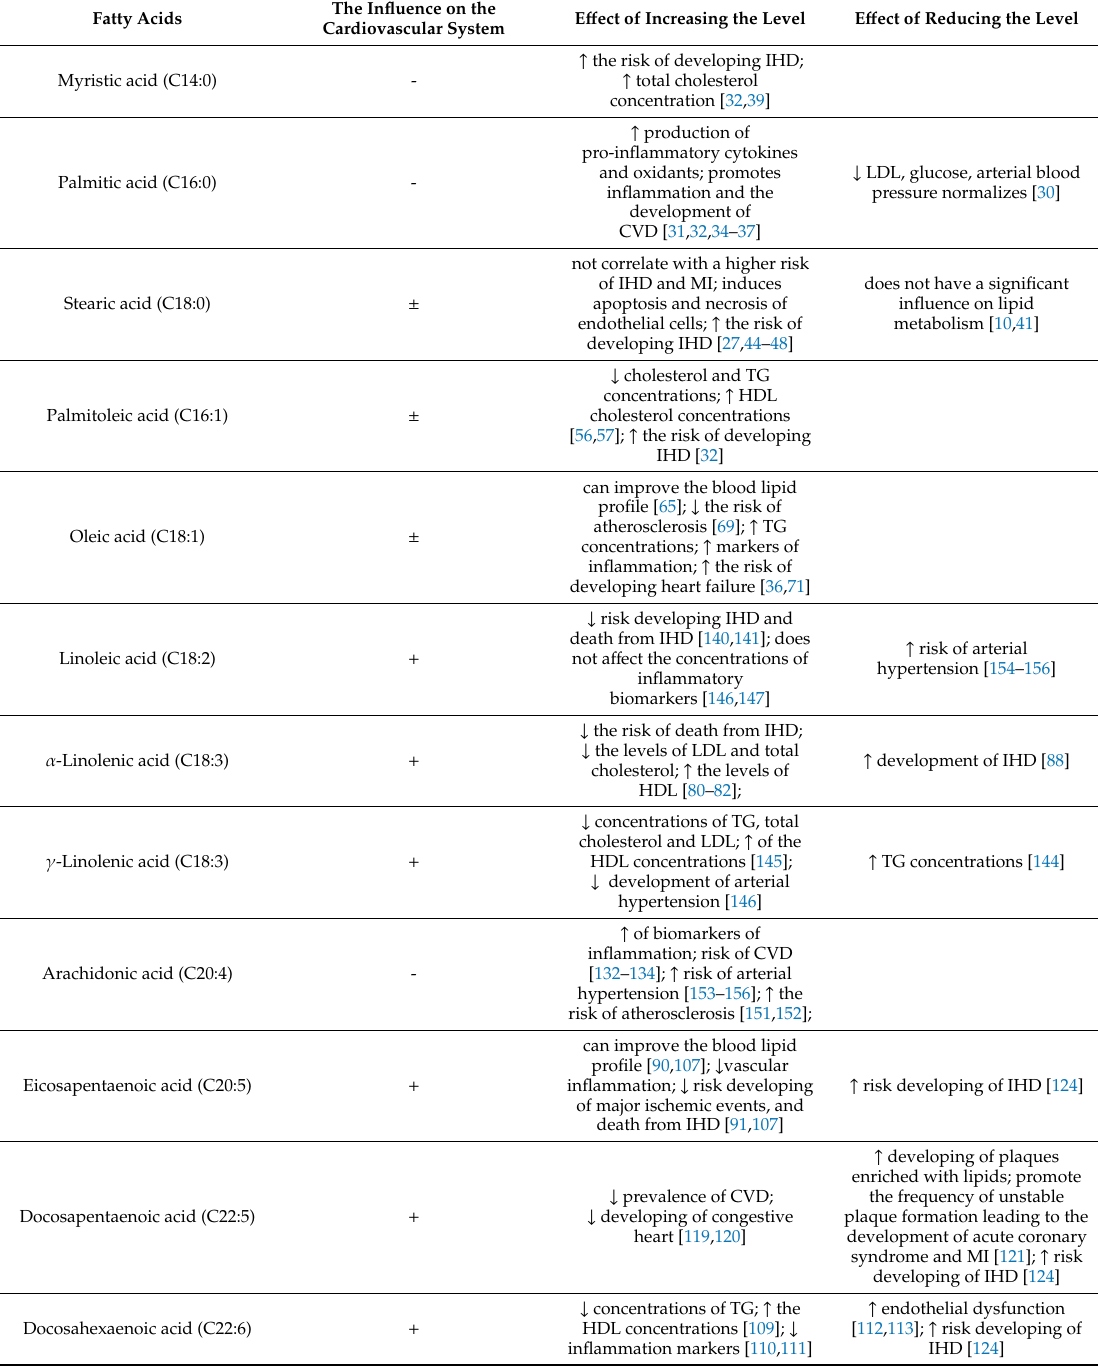
Table 4. The influence of fatty acids on the cardiovascular